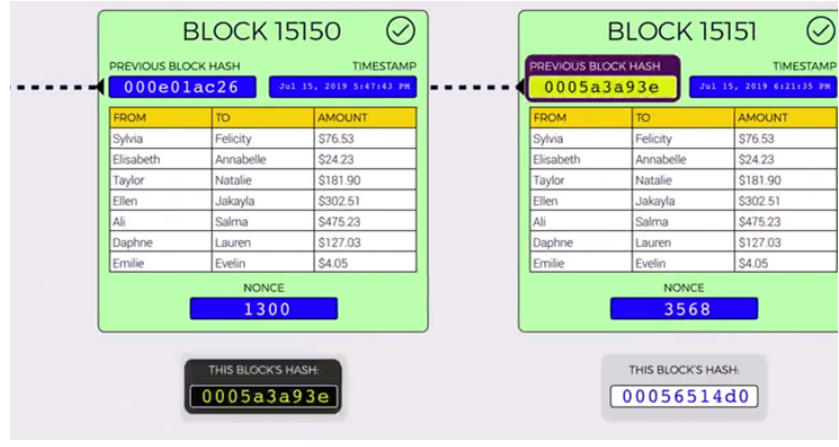
Figure 3. Chain of